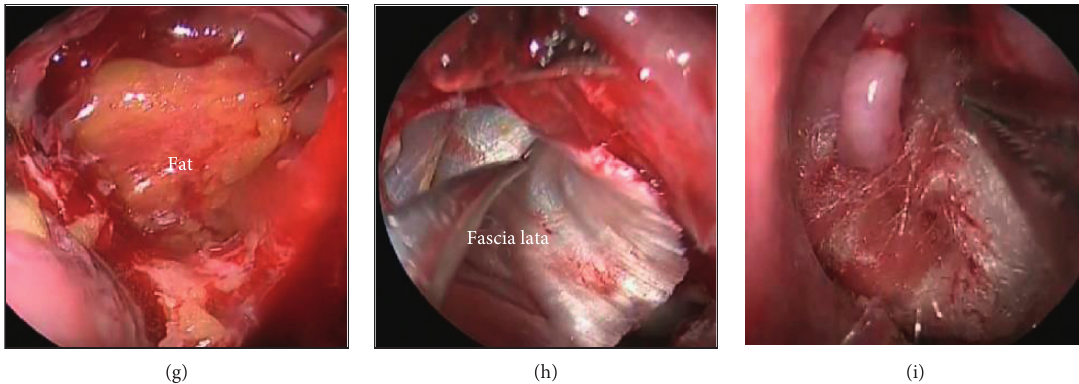
Figure 4: Surgical findings. (a) Remedial surgery is performed on the nasal septum with exfoliation of the vomer bone. (b) Approximately one-third of the lower middle nasal concha is removed on both sides. (c) The rear end of the membranous septa is removed on both sides. (d) The vomer bone is removed by drilling, and (e) the frontal cystic wall is resected with the pituitary scalpel. (f) Bones of the cranial base showed thinning, with pulsations and dura mater observed through them (black arrow). r IC, right internal carotid artery and l IC, left internal carotid artery. (g), (h) Cranial base reinforcement using fat and fascia collected from the femur, and (i) hemostatic packing.